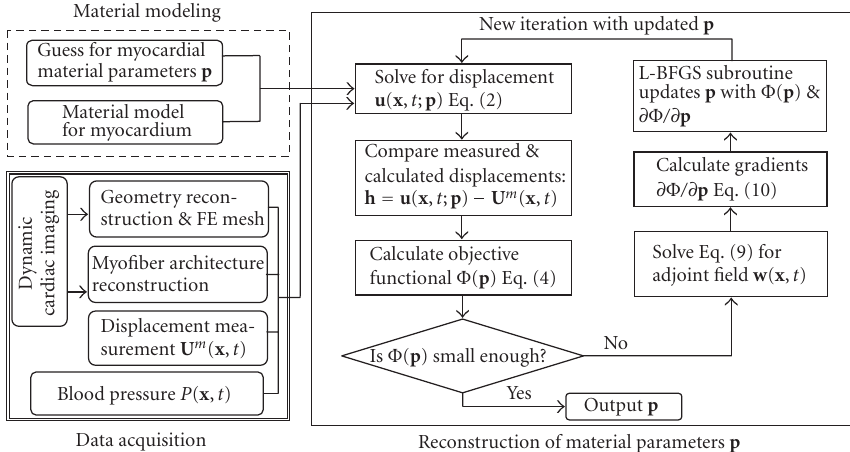
Figure 1: Flowchart for the DCE reconstruction procedure with L-BFGS optimization subroutine and user-supplied